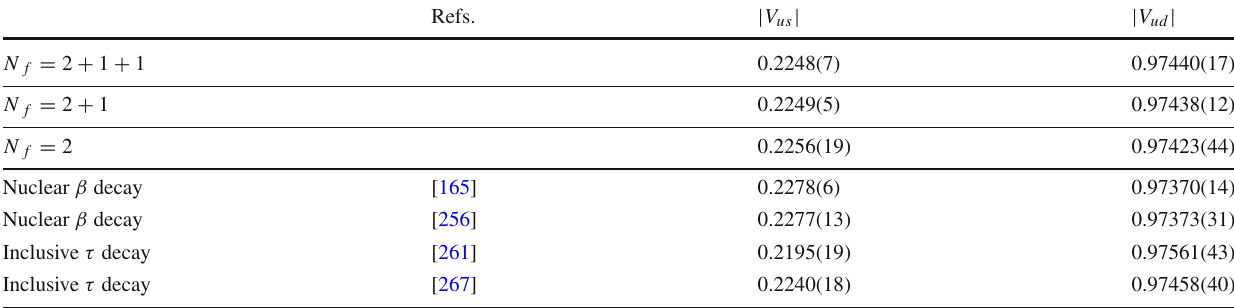
Table 19 The upper half of the table shows our final results for | V us | , | V ud | , f + ( 0 ) and f K ± / f π ± that are obtained by analysing the lattice data within the Standard Model (see text). For comparison, the lower half lists the values that follow if the lattice results are replaced by the experimental results on nuclear β decay and inclusive hadronic τ decay, respectively